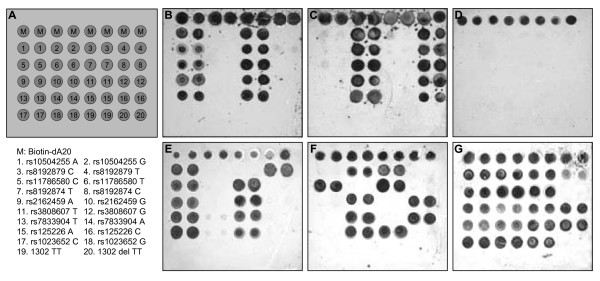
Genotyping of the 10 markers of CYP7A1 htSNPs and small deletion on thin-film biosensor chips. A. A design for arraying the capture probes on a thin-film biosensor chip. A pair of capture probes for each SNP were arrayed in duplicate next to each other with allele 1 left and allele 2 right. M indicates a positive control marker with 20 dATP and 3'-biotin. B. SNP discrimination with a pool of synthetic oligonucleotide targets of allele 1. C. SNP discrimination with a pool of synthetic oligonucleotide targets of allele 2. D. Negative control with no targets. E. A representative image showing genotypes of a Mexican-American individual with homozygous allele 1 for the most markers, but homozygous allele 2 for rs8192879. F. A representative image showing genotypes of a Mexican-American individual with homozygous allele 2 for the most markers, but homozygous allele 1 for rs18192879, rs11786580, rs8192874, 1302 TT. G. A representative image showing genotypes of a Mexican-American individual with heterozygous for the most markers except rs8192874, 1302 TT.